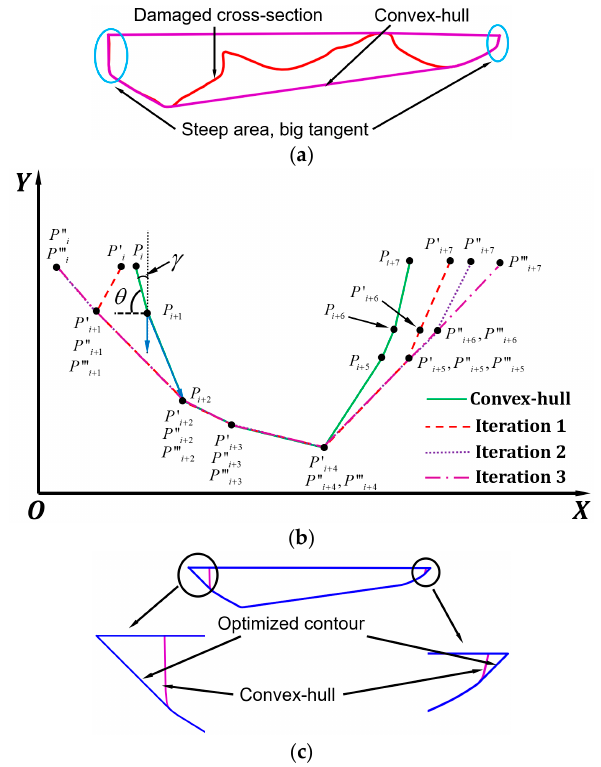
Figure 8. Sidewall inclination angle optimization for the convex-hull boundary (CHB). ( a ) CHB processed on a damaged cross-section; ( b ) schematic diagram showing optimization algorithm; ( c ) optimized contour.